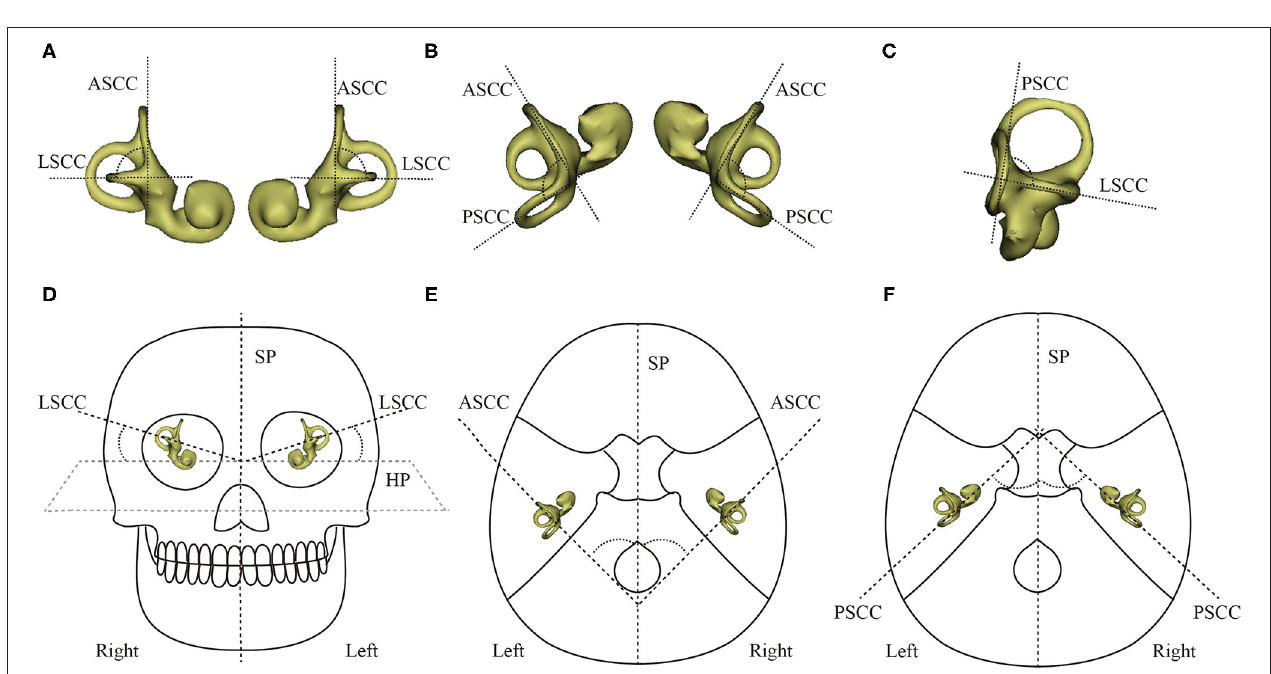
FIGURE 3 | Four different coordinate planes. Point a is the vertex of the bilateral superior semicircular canals. Point b is the center of the eyeball. Point c is the bifurcation of the common crus. Point d is the inferior margin of the orbit. W-HP, S-HP, F-HP, and R-HP refer to the horizontal planes of the W–X, Suzuki, Frankfurt, and Reid coordinate systems, respectively.